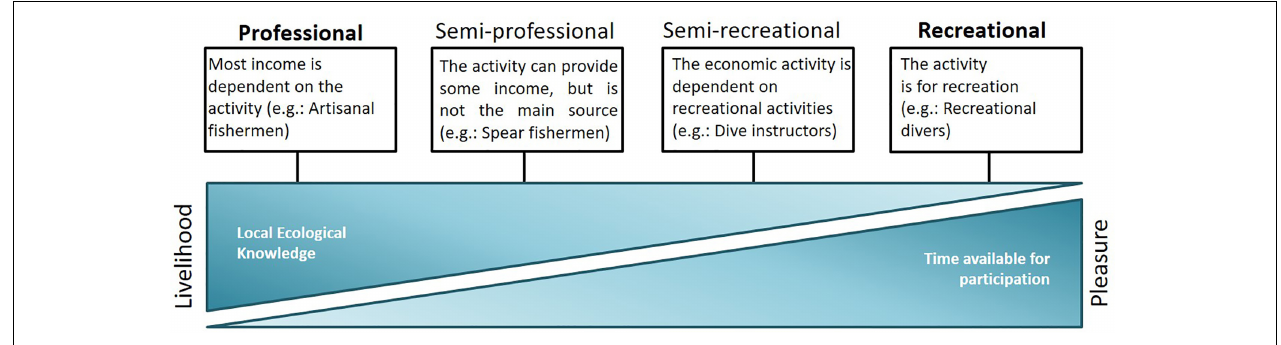
FIGURE 4 | Differences between potential volunteers in CS based on their economic dependence on the activity related to a CS project.